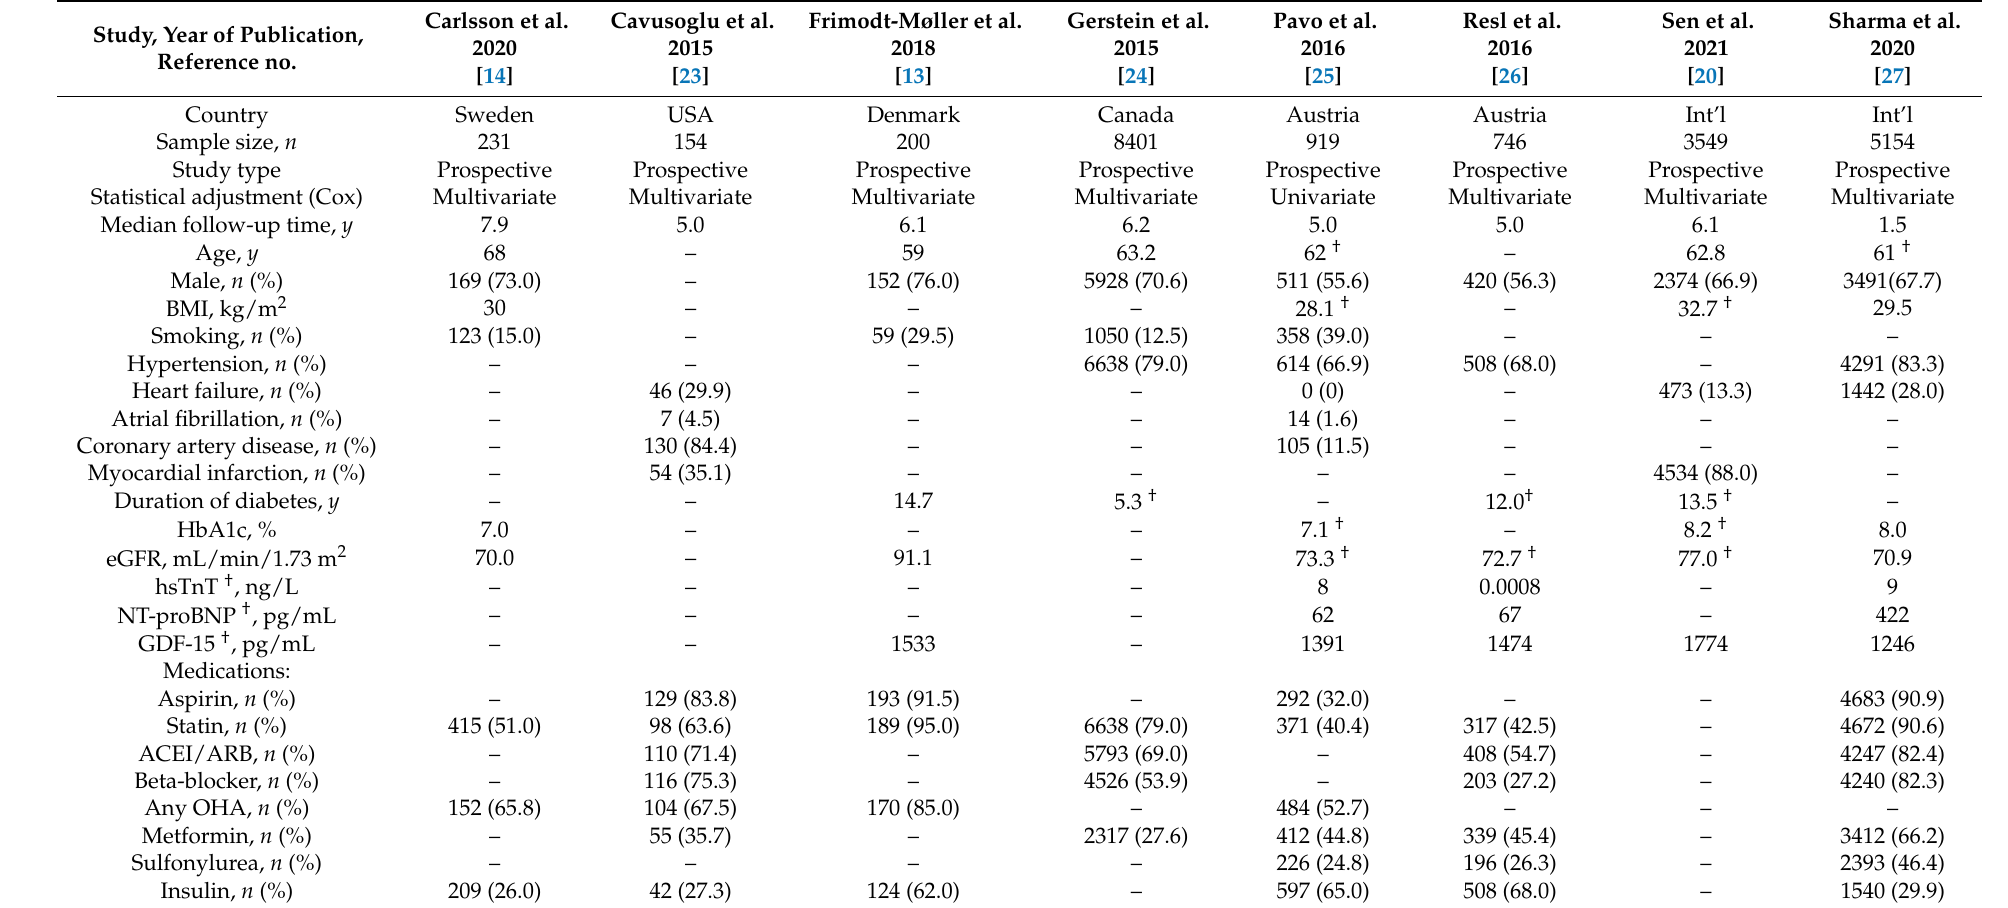
Table 1. Summary of prospective studies in this